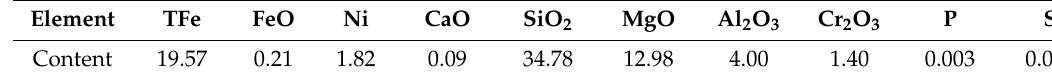
Table 1. Chemical composition of the laterite nickel ore (wt %).